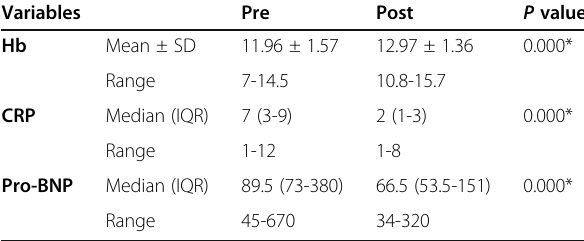
Table 4 Paired comparison of laboratory values